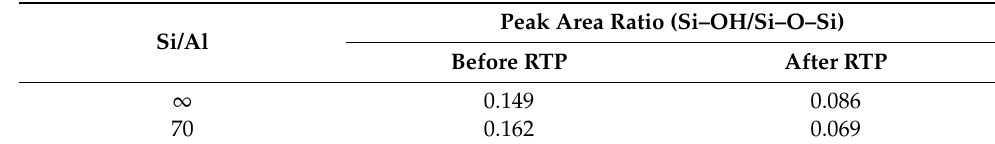
Table 5. Peak area ratios of the silanol concentration of the ZSM-58 membrane with different Si/Al molar ratios measured by FTIR.